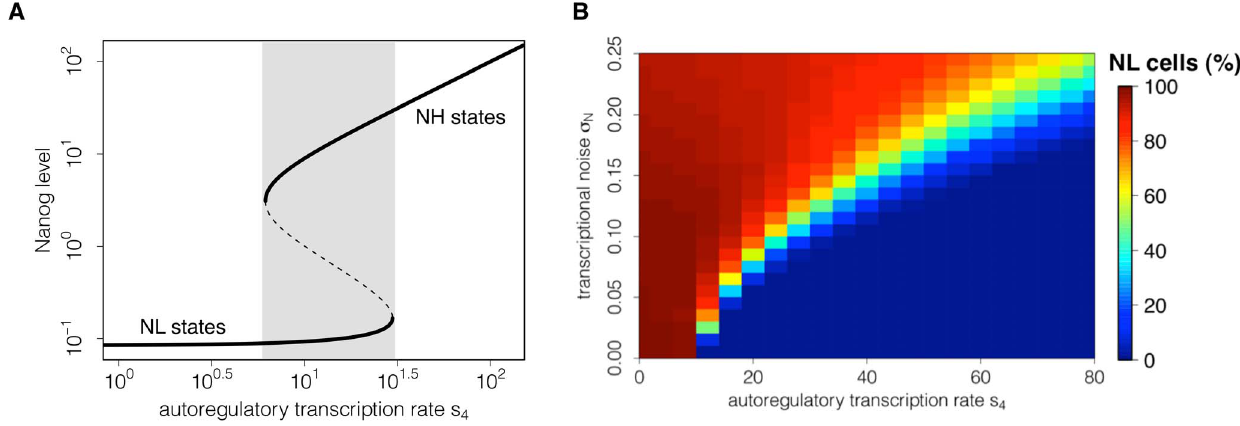
Figure 2. Dependency of stable Nanog states on Nanog autoregulation and noise. (A) The bifurcation diagram indicates the existence of Nanog states depending on the autoregulatory transcription rate s 4 . The lower solid line shows the existence of Nanog-low (NL) states and the upper solid line shows the existence of Nanog-high (NH) states. Within the bistable region (shaded in grey) coexisting stable states are separated by unstable states (dashed line). (B) Simulating a cell population, the heat map illustrates the proportion of NL cells depending on the transcription rate s 4 and on the transcriptional noise s N at time point t=4320min (i.e. 3 days of in silico culture). For any value of the background noise, an increase in the transcription rate s 4 reduces the proportion of NL